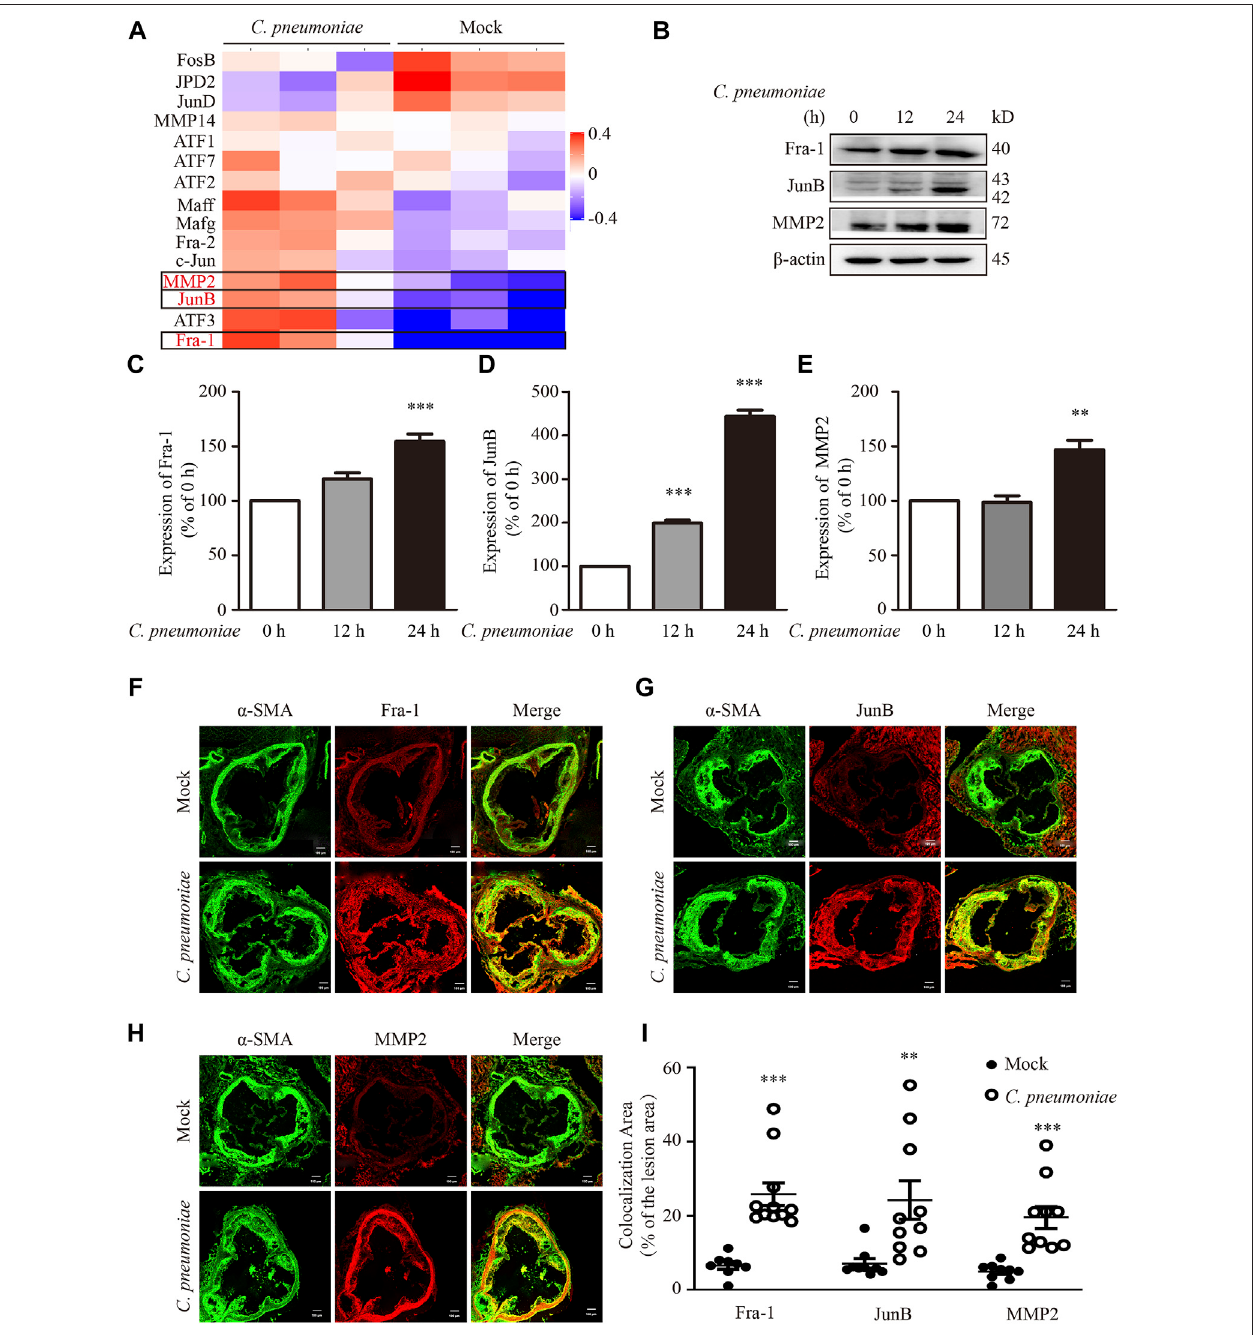
FIGURE 4 | C. pneumoniae infection upregulates Fra-1, JunB and MMP2 expressions. (A,B) VSMCs were infected with C. pneumoniae (5 × 10 5 IFU). (A) DifferentiallyexpressedproteinsinAP-1familyandMMPfamilymembersinVSMCsafter C.pneumoniae infection. (B) RepresentativeWesternblotresultsofFra-1,JunB andMMP2fromVSMCsthathadbeeninfectedwith C.pneumoniae fortheindicatedtimepoints. (C – E) Theexpressionratiooftheindicatedproteinto β -actinfromthree independent experiments is presented. ** p < 0.01, *** p < 0.001, compared with C. pneumoniae infection 0 h group, as analyzed by one-way ANOVA. (F – H) The expressions of Fra-1 (F) or JunB (G) or MMP2 (H) in VSMCs in atherosclerotic lesions of ApoE -/- mice fed a Western diet for 6 weeks with or without C. pneumoniae infection.Scale bar:100 μ M. (I) Quanti fi cationofactiveFra-1 + ,JunB + andMMP2 + VSMCsinthelesions ofaortic sinusfrom ApoE -/- micefedaWestern dietfor6 weeks with or without C. pneumoniae infection. ** p < 0.01, *** p < 0.001, compared with mock infection groups, as analyzed by Student ’ s t -test.